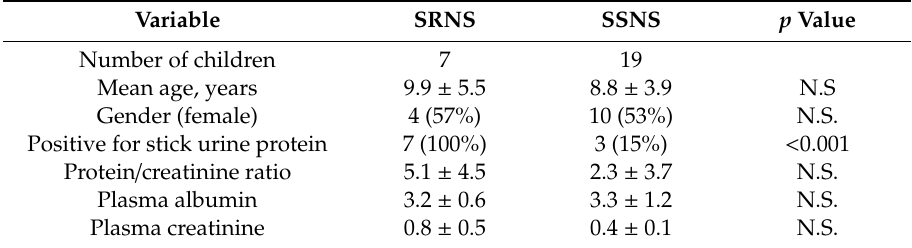
Table 2. Demographic and clinical characteristics of children with nephrotic syndrome according to